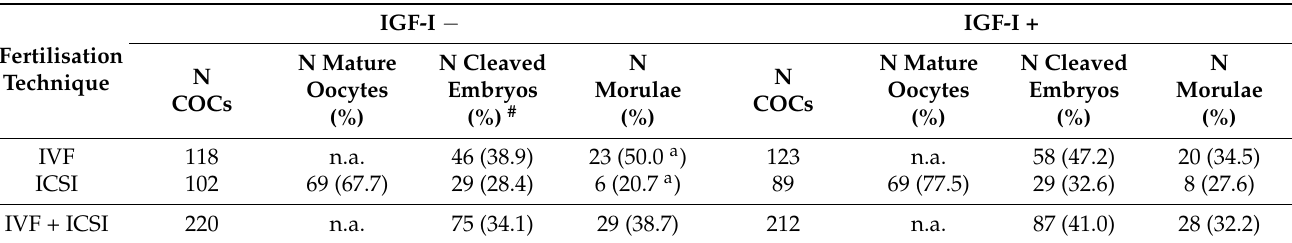
Table 2. Experiment B (Berlin): Summary of the development of embryos obtained with IVM and different fertilisation methods with or without the addition of 20 ng/mL of IGF-I to single cultures.